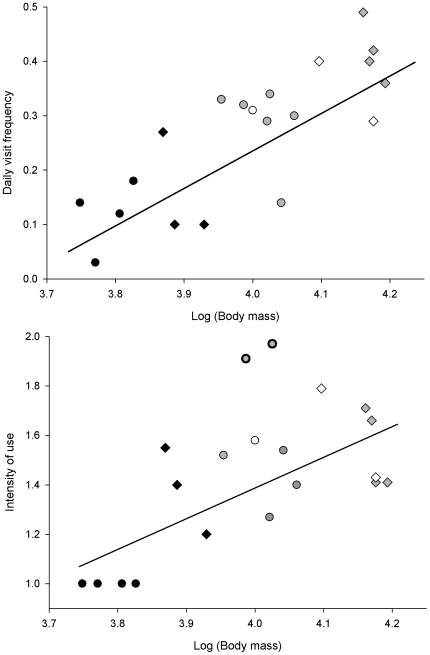
Regression between indices of supplementary food use and Iberian lynx body mass (g).Upper panel: daily visit frequency, R2 = 0.655; lower panel, intensity of use, R2 = 0.518. Grey diamonds: adult males; grey circles: adult females; white diamonds: subadult males; white circles: subadult female; black diamonds: juvenile males; black circles: juvenile females. We excluded two anomalous adult females (edges marked in bold) in the analysis of intensity of use because one of them did not share her territory with any adult male, and the other exhibited a marked dependence upon supplementary food after being recovered in captivity during February 2006.